Question: What direction does the quantity move in — increasing or decreasing?
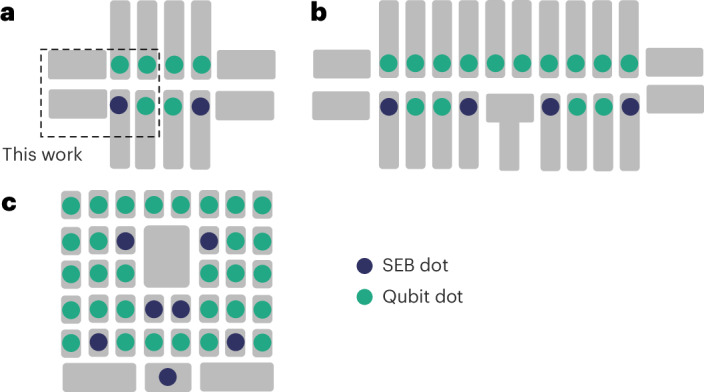
Answer: increasing